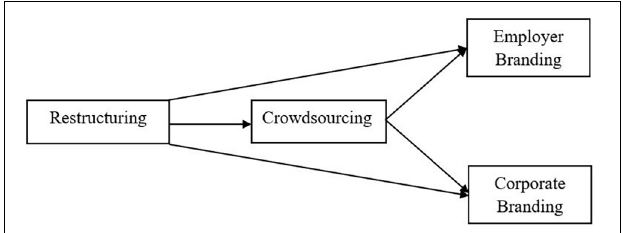
FIGURE 1 | The research